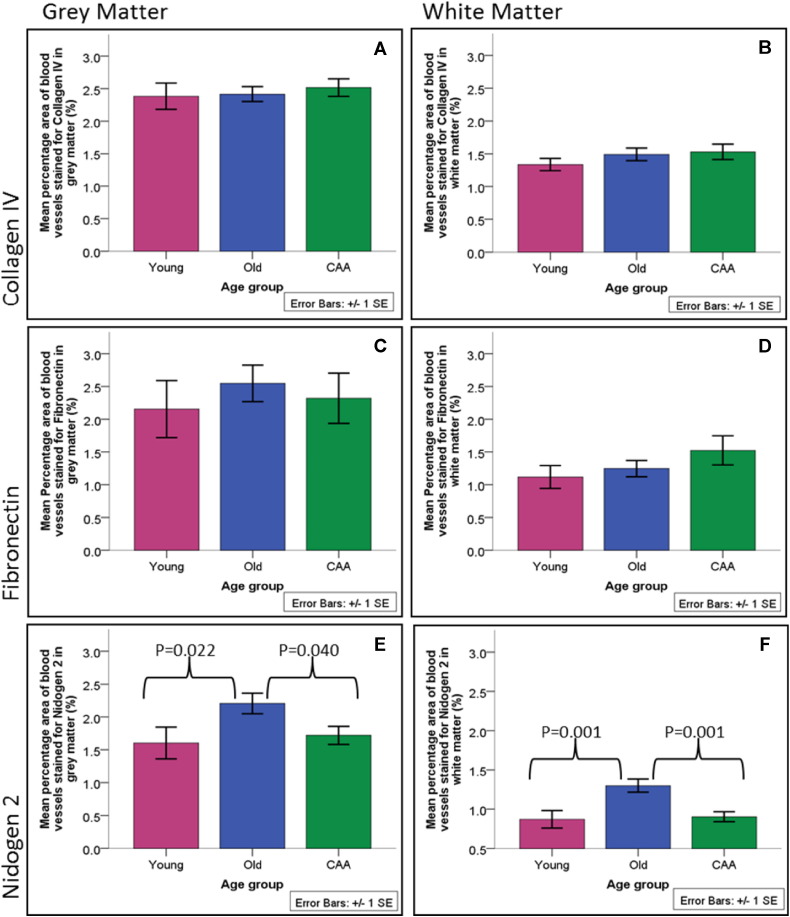
Quantification for collagen IV, fibronectin, nidogen 2 in the gray and white matter of young, old and CAA cases. The percentage areas stained with nidogen 2 in gray and white matter were significantly higher in old compared to young brains and significantly lower in CAA brains compared to old brains.